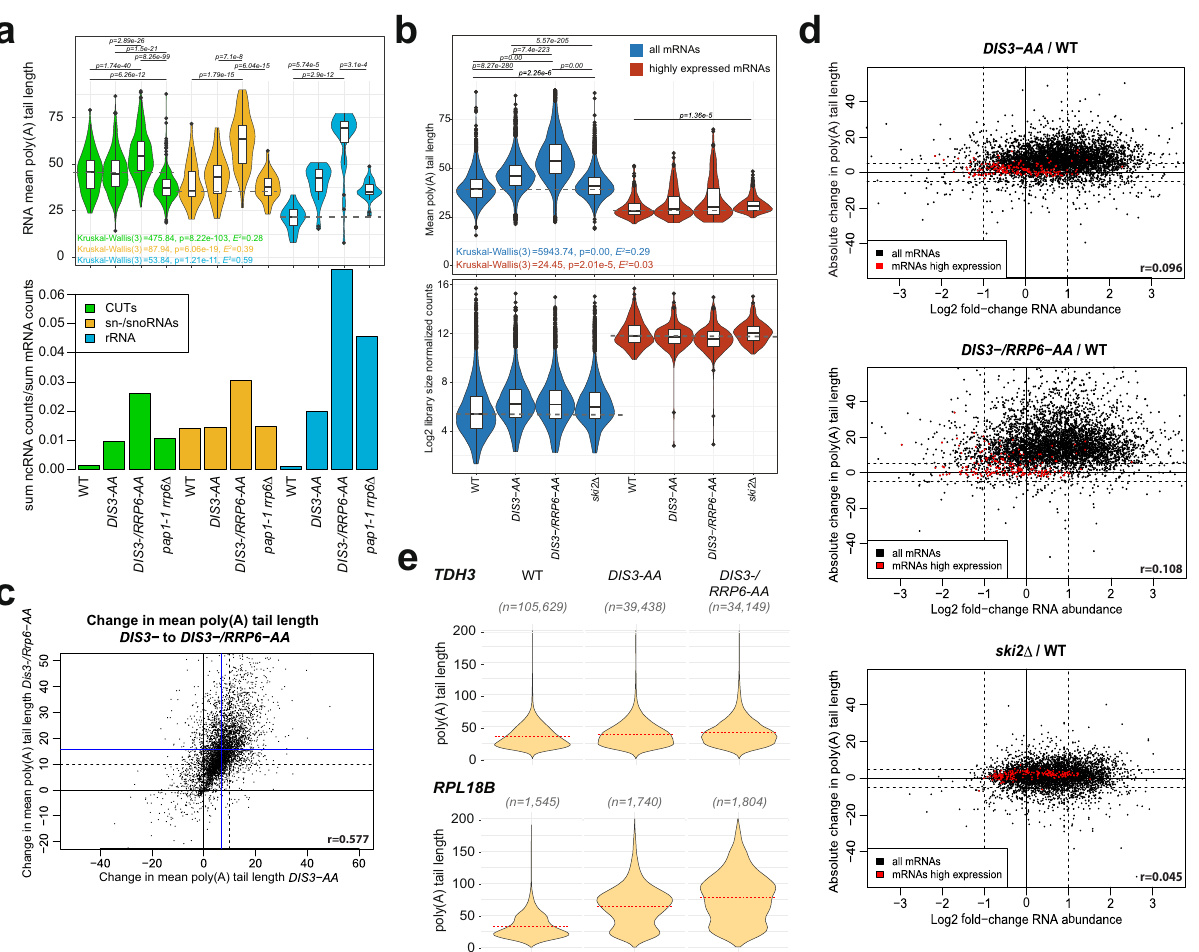
Fig. 4 Dis3 and Rrp6 mediate extensive mRNA poly(A) tail trimming. a Violin plot of mean poly(A) tail lengths of CUTs, snRNAs, and rRNAs detected in WT, DIS3-AA , DIS3-/RRP6-AA , and pap1-1 rrp6 Δ cells (top), and the sum of all DRS counts that map to those ncRNA loci, normalized to the sum of counts mapped to protein-coding loci (bottom). The number of RNAs detected n = [WT, Dis3-AA , Dis3-/Rrp6-AA, pap1-1 rrp6 Δ ] was for CUTs = [143, 436, 579, 434], sn/snoRNAs = [36, 52, 59, 59], and rRNAs = [17, 23, 24, 23]. For the upper panel, Kruskal – Wallis test P value and Holm-corrected P values for two- sided Dunn pairwise test are shown. Dashed gray lines show the mean values for WT strain to ease visual comparison. Box plots show median value (solid bold line) and 1st and 3rd quartiles, whiskers represent 1.5 × IQR (interquartile range). Outliers are marked as black points. b Mean mRNA poly(A) tail lengths (top panel), and log2 mRNA abundance (bottom) for WT ( n = 5079), DIS3-AA ( n = 5035 ) , DIS3/RRP6-AA ( n = 5109) and ski2 Δ ( n = 5081) strains. Data for highly expressed mRNAs are shown in red. For the upper panel, Kruskal – Wallis test P value and Holm-corrected P values for two-sided Dunn pairwise test are shown. Dashed gray lines show the mean values for WT strain to ease visual comparison. Box plots show median value (solid bold line) and 1st and 3rd quartiles, whiskers represent 1.5 × IQR (interquartile range). Outliers are marked as black points. c Relationship between absolute change in mean poly(A) tail length between DIS3- and DIS3-/RRP6-AA cells compared with WT. Blue lines designate the mean poly(A) tail length change in each strain. Dashed lines mark a 10-adenosine change of mean poly(A) tail length. d Relationship between absolute change in mean mRNA poly(A) tail length and log2 fold-change mRNA abundance for DIS3-AA , DIS3-/RRP6-AA , and ski2 Δ cells, respectively, compared with WT. Dashed lines show a twofold change in expression and a 5-adenosines change of poly(A) tail length. e Violin plots of the poly(A) tail length distribution of DRS reads for TDH3 and RPL18B mRNAs for WT, DIS3-AA , and DIS3-/RRP6-AA . The number of DRS reads for each condition is shown for each transcript. Red dashed lines show the mean for each condition. Pearson ’ s correlation coef fi cients are indicated on each